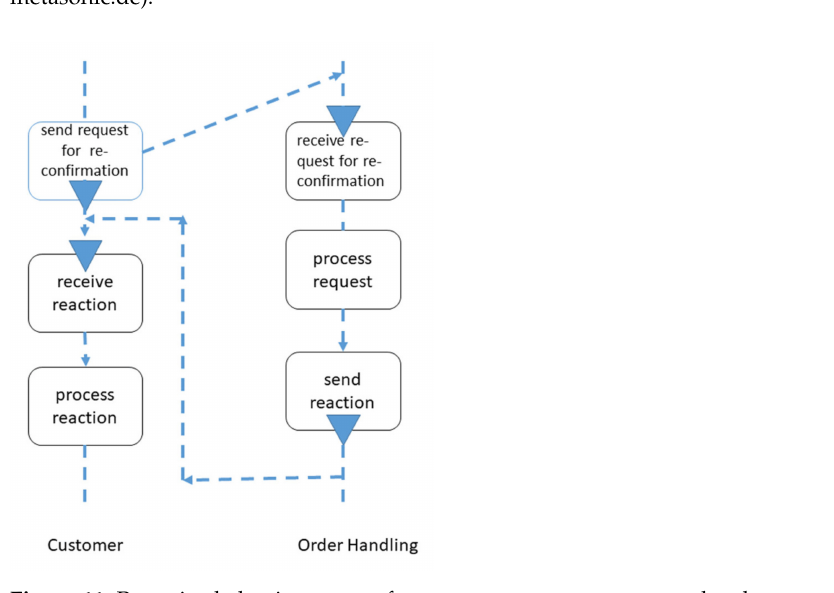
Figure 11. Proactive behavior pattern for a customer request on an order